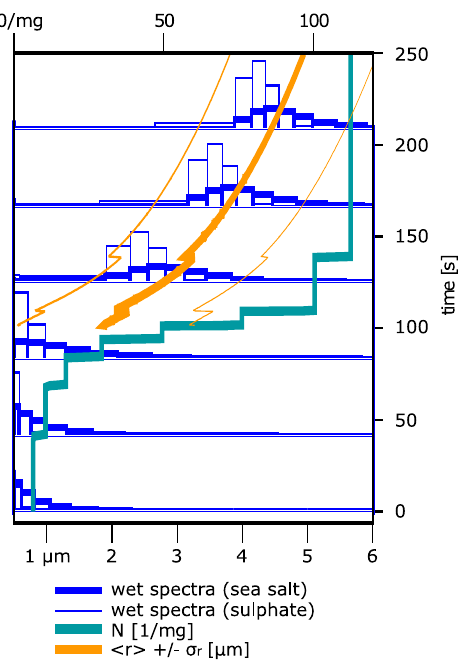
Fig. 3. A summary of the evolution of droplet spectrum as calculated in the model run discussed in Sect. 3.1. The wet spectra are drawn at six selected time-steps using separate histograms for sulphate (thin blue lines) and sea-salt (thick blue lines). The vertical scaling factor is the same for all twelve histograms, and has an arbitrary value. The thick orange line denotes average droplet radius, while the two surrounding thin orange lines represent the width of the spectrum ( ± σ r ). Both the average radius and the standard deviation are shown only after the specific concentration reaches 50mg − 1 . The turquoise line denotes specific droplet concentration (units at the top